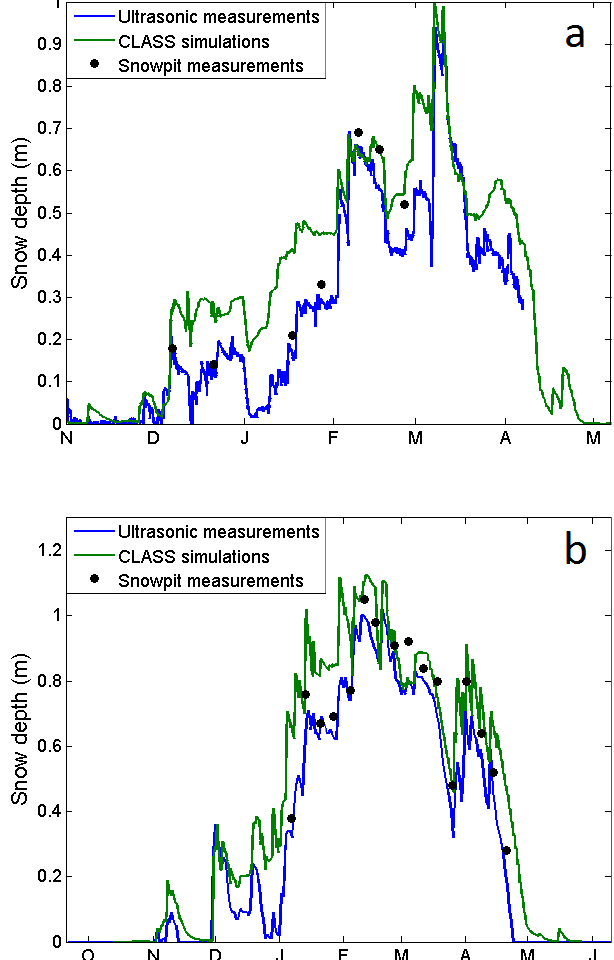
Fig. 4. CLASS snow depth simulations compared with Ultrasonic Fig.4: CLASS snow depth simulations compared with Ultrasonic measurements at a) 1110 measurements at (a) SIRENE and (b) Col de Porte. Black dots are SIRENE and b) Col de Porte. Black dots are the snow depths from snowpit 1111 measurements.1112 the snow depths from snowpit